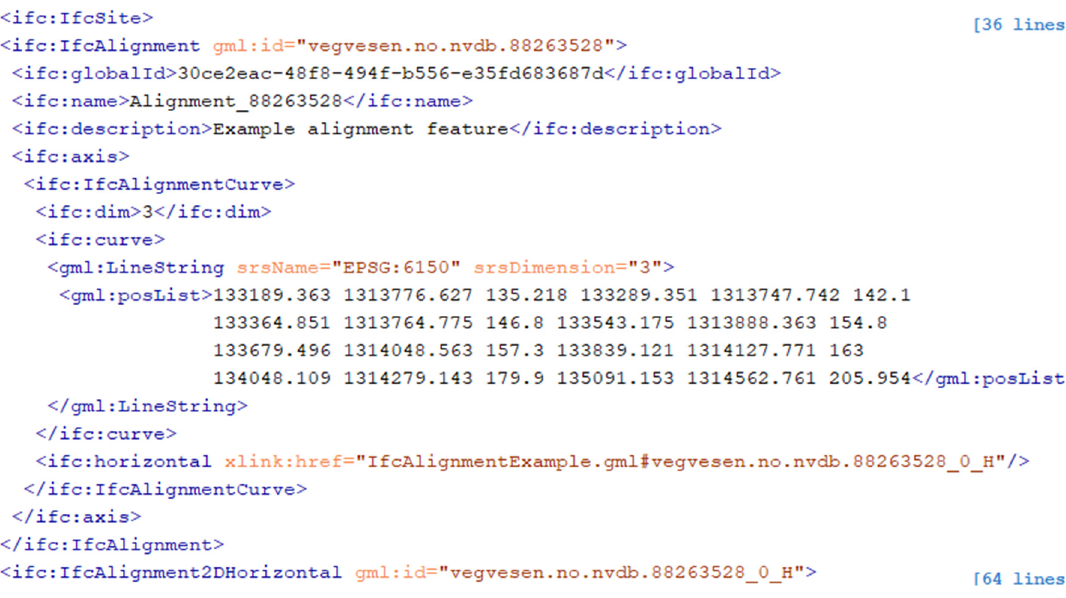
Figure 19. Extract of an example GML file for IFC.